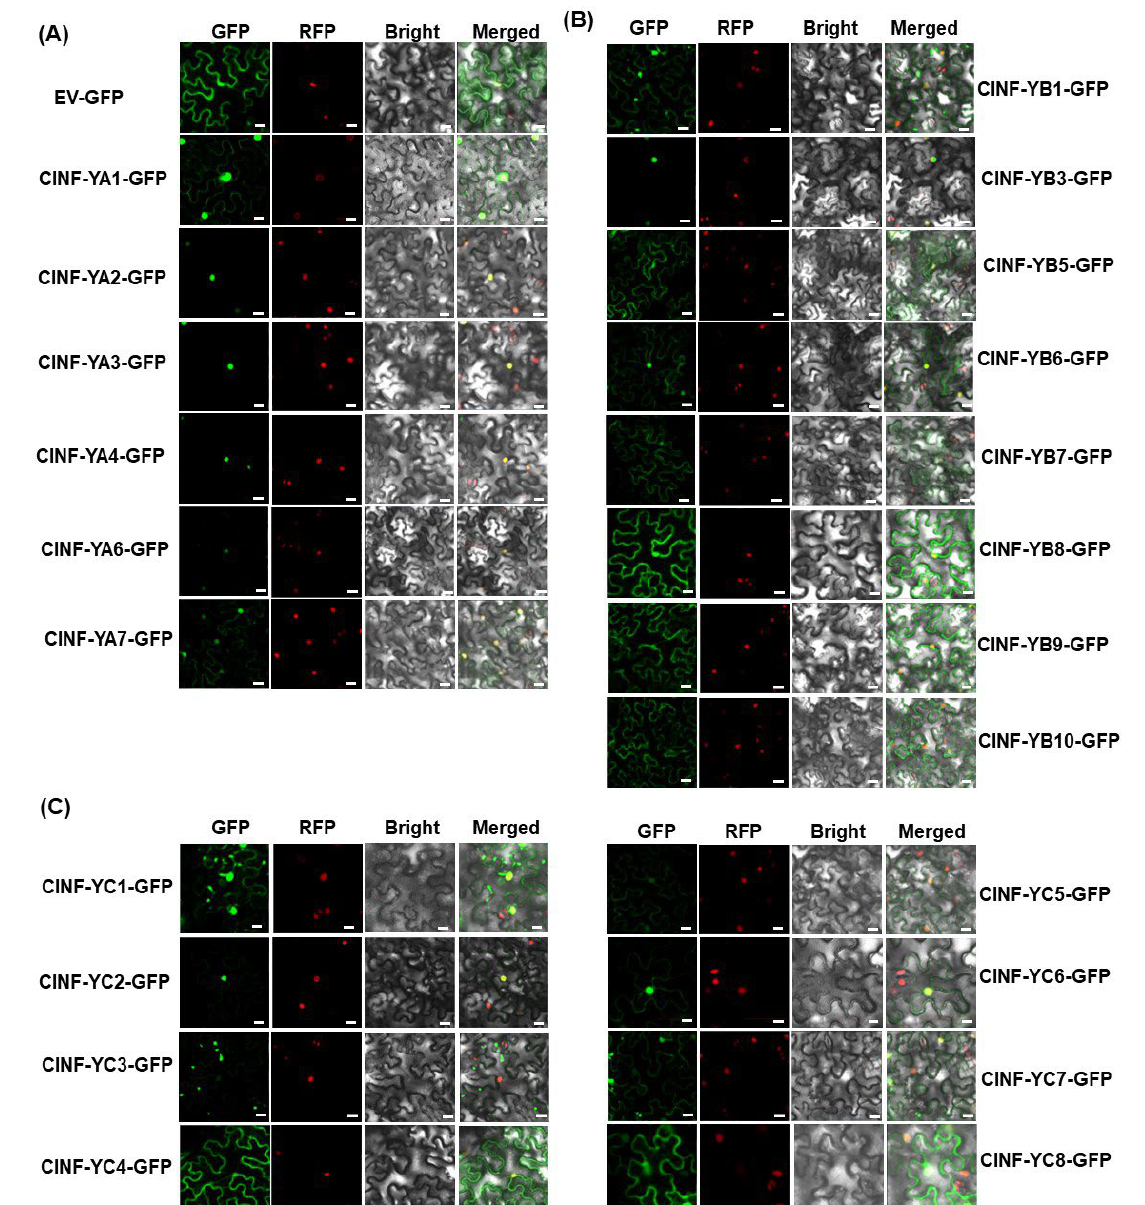
Figure 5. Subcellular localization of watermelon ClNF-Y proteins. ( A ) ClNF-YA subunits; ( B ) ClNF-YB subunits; ( C ) ClNF-YC subunits. Agrobacteria carrying pCAMBIA1300-ClNF-YAs-GFP, pCAMBIA1300-ClNF-YBs-GFP, pCAMBIA1300-ClNF-YCs-GFP, or pCAMBIA1300-GFP were infiltrated into leaves of N. benthamiana plants expressing a known nucleus-localized marker protein RFP-H2B. At 48 h after agroinfiltration, the GFP signal was visualized under a confocal laser scanning microscope in a dark field for green fluorescence ( left ) and red fluorescence ( middle left ), a white field for cell morphology ( middle right ), and in combination ( right ). Scale bars, 20 μm. Experiments were performed three times with similar results.